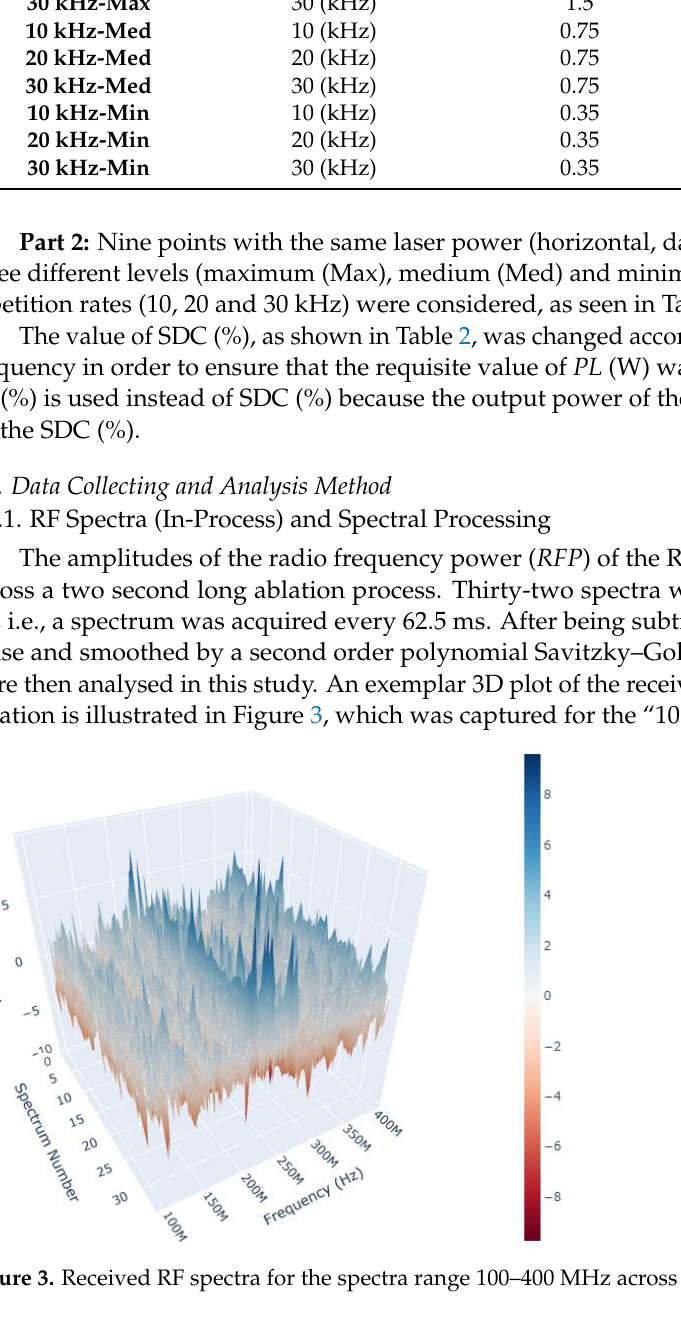
Table 2. RRL (kHz), PL (W) and SDC (%) for nine points in the “Part 2” experiments.